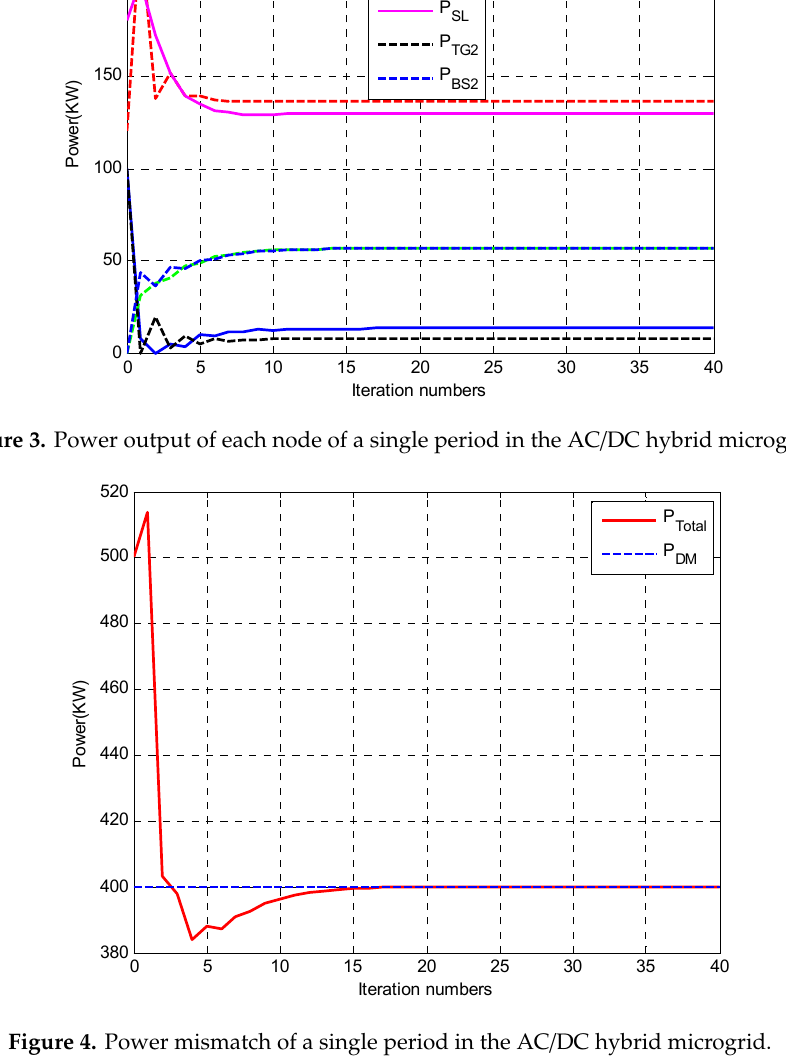
Figure 4. Power mismatch of a single period in the AC/DC hybrid microgrid.